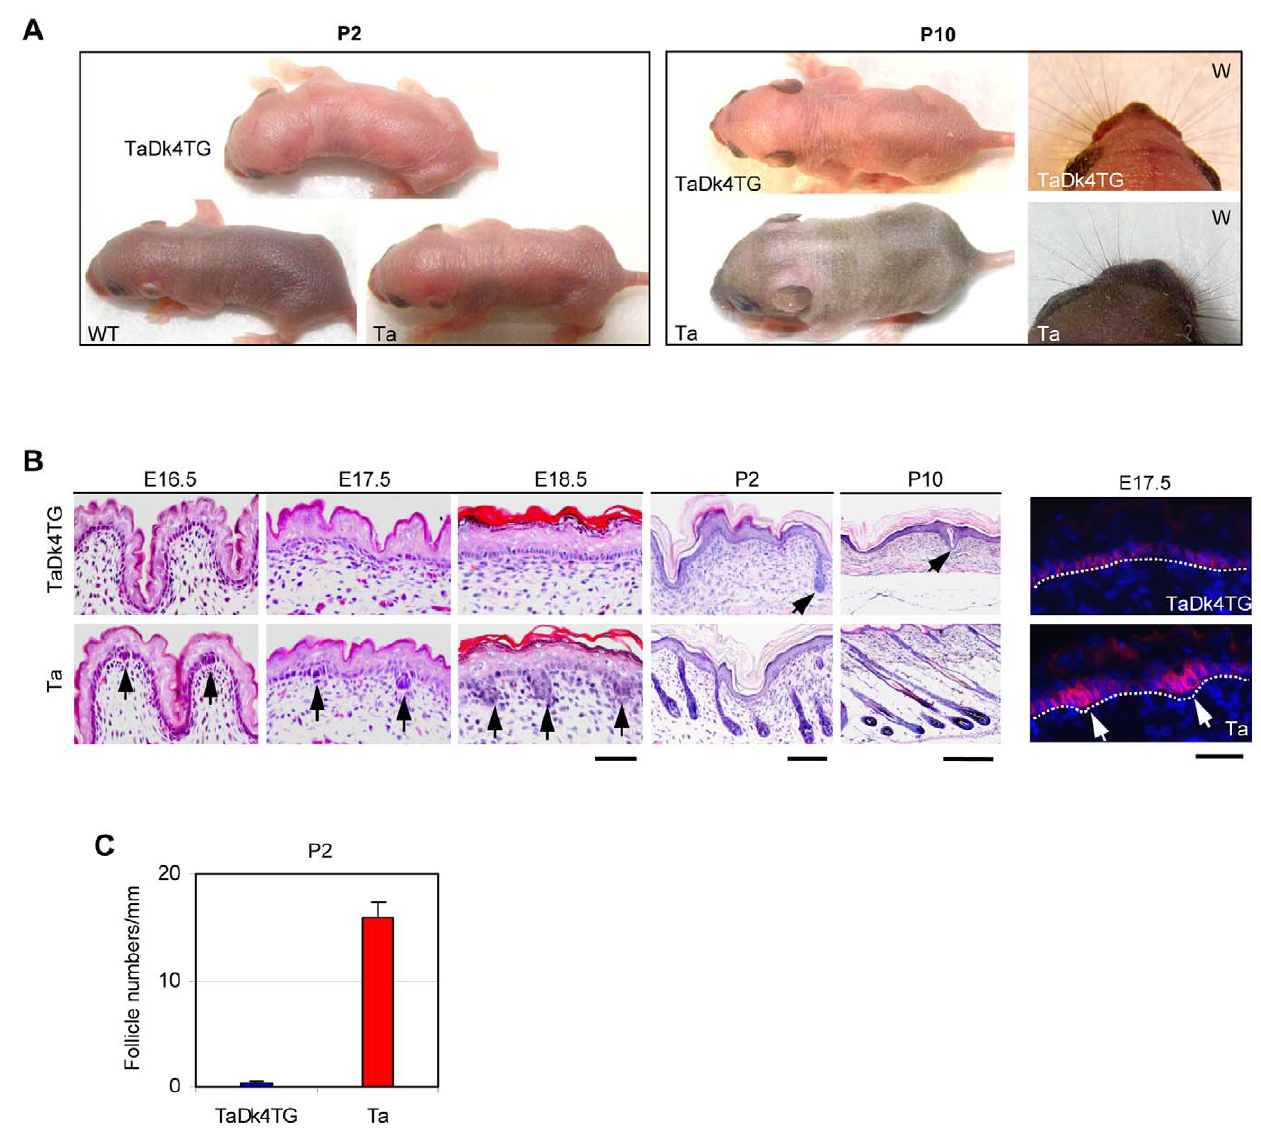
Figure 4. A Dkk4 transgene completely blocked hair follicle induction in Tabby mice. A, Growing hair made WT pups black and Ta pups grey, but TaDk4TG pups were pink with thin and translucent skin at P2. At P10, TaDk4TG pups were complete hairless, but Ta pups showed a dense yellowish hair coat. Notably, TaDk4TG pups developed normal whiskers (W in right corner) as did Ta. B, Histological progression of hair follicle development in Ta and TaDk4TG mice. Hair follicle germs were discernible at E16.5 and grew down thereafter (arrows in lower panels), stage 4 to 5 hair follicles were seen at P2, and stage 7 to 8 follicles were clear at P10 in Ta mice (lower right panel). Hair follicle induction was not detected in TaDk4TG mice in the embryonic stages, but a late-forming hair follicle was occasionally found at P2, and an epidermal invagination was seen at P10 (arrows in P2 and P10). TaDk4TG skin lacked a fatty layer at P10. Immunofluorescent staining of P-cadherin confirmed hair germ formation in Ta at E17.5 (arrows in right panels), but not in TaDk4TG embryos. Scale bars for embryos, 400 m m; for P2, 1000 m m; for P10, 200 m m; for P-cadherin, 50 m m. C, The retarded hair follicles formed in TaDk4TG mice numbered less than 2% of the hair follicles in Ta littermates.